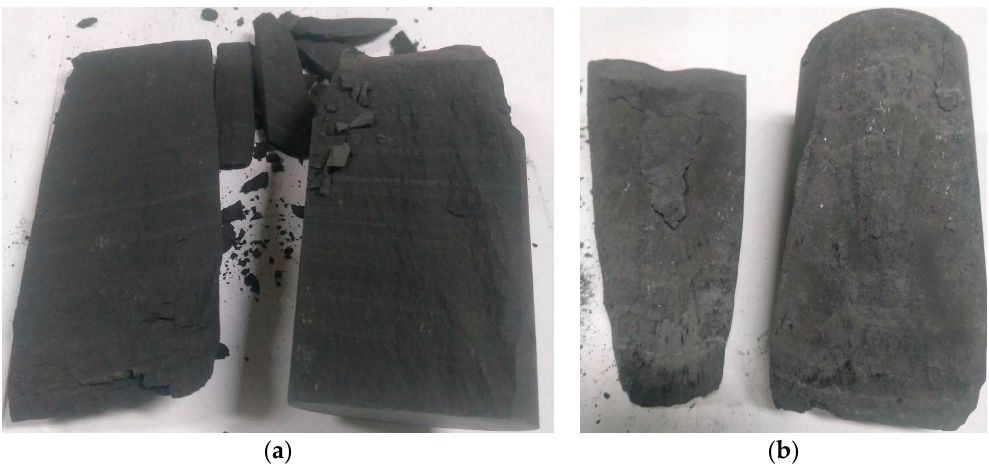
Figure 7. ( a ) Extension fracturing surfaces of sample S30-0 ( β = 30° and σ 3 = 0 MPa); and, ( b ) shear fracturing surfaces of sample S30-60 ( β = 30° and σ 3 = 60 MPa).